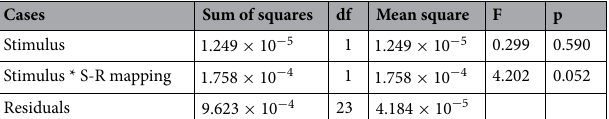
On average, participants were shown 49.82 ± 2.42% (mean ± standard deviation, N = 25 ) of “number+sound” stimuli, indicating the quasi-equiprobability of each stimulus. We then performed mixed-model ANOVAs on their RTs and response accuracy for both stimulus-response mapping (between-subject factor) and stimulus (within-subject factor). Across all participants and stimulus types, the mean RT is 535 ± 61 ms , with an accuracy of 98.59 ± 0.95% . For the “face” stimulus, participants responded after 539 ± 56 ms with an average accuracy of 98.51 ± 1.17% . Participants responded to the “number + sound” stimulus after 531 ± 69 ms on average with an accuracy of 98.68 ± 0.94% . The difference in performance between the types of stimuli is not significant in terms of accuracy (Table 1) nor RTs (Table 2). In the “face-left” stimulus-response mapping, where participants were instructed to click left upon face stimu- lus presentation and right when they were presented with a number+sound stimulus, participants responded on average within 531 ± 74 ms with an accuracy of 98.48 ± 1.12% ( N = 15 ). Participants who underwent the “face- right” mapping ( N = 10 ) responded within 541 ± 30 ms with an accuracy of 98.77 ± 0.60% . The effect of the stimulus-response mapping on accuracy and RT was not significant (Tables 3 and 4). We note a marginal interac- tion effect between stimulus-response mapping and stimulus type on the accuracy ( p = 0.052 , Table 1). However, pairwise post-hoc comparisons revealed no difference between interaction sub-conditions ( p Holm > 0.310 ). These results show the uniformity of participant responses across mappings and stimuli.